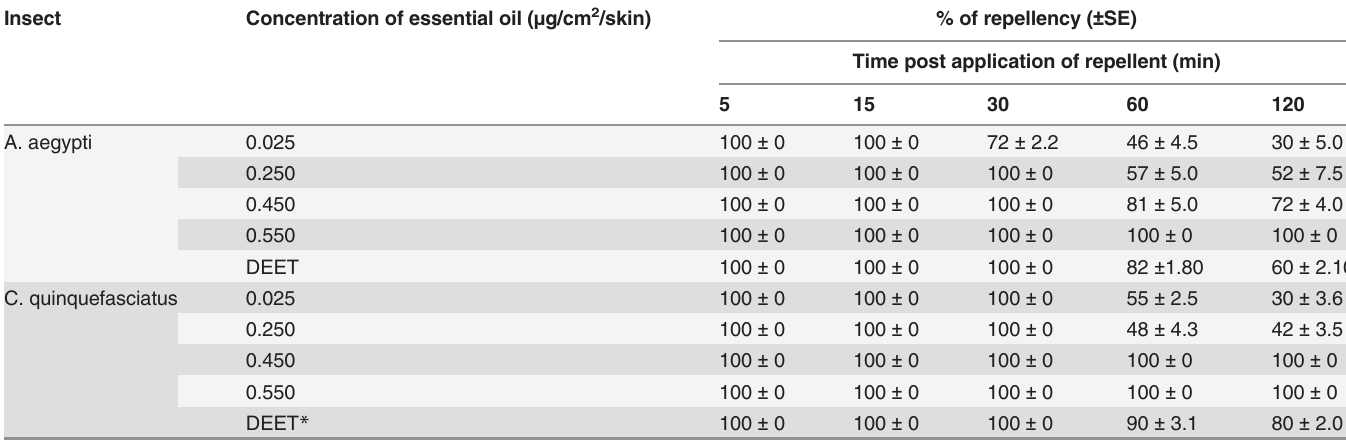
Table 6. Protective activity of S . guianensis essential oil against C . quinquefasciatus and A . aegypti . Insect